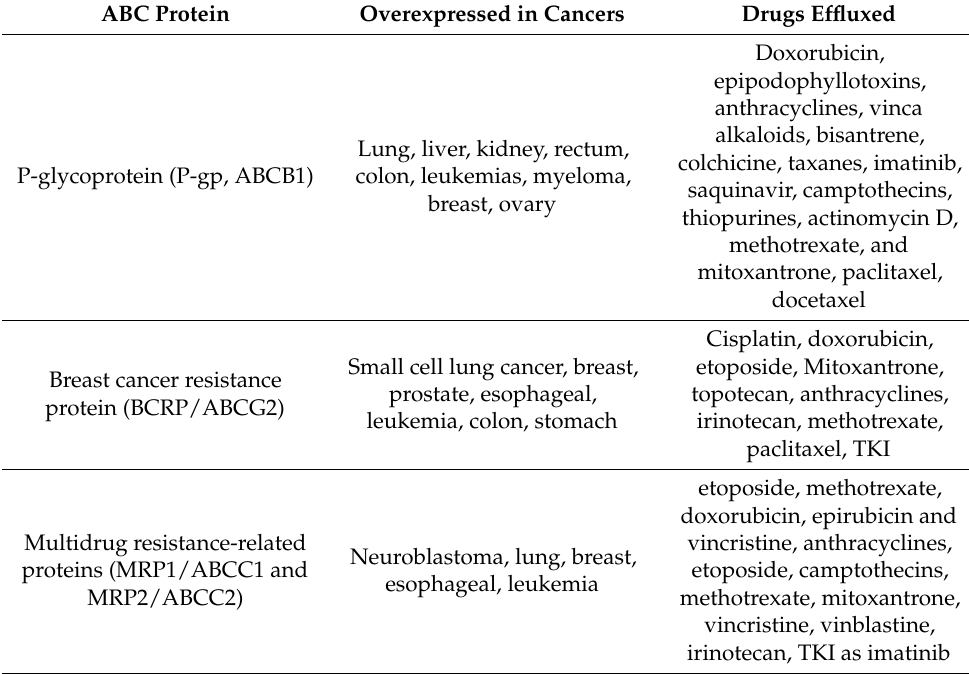
Table 1. Overexpressed ABC proteins affecting the efflux of chemotherapeutic drugs in human cancers. ABC Protein Overexpressed in Cancers Drugs Effluxed